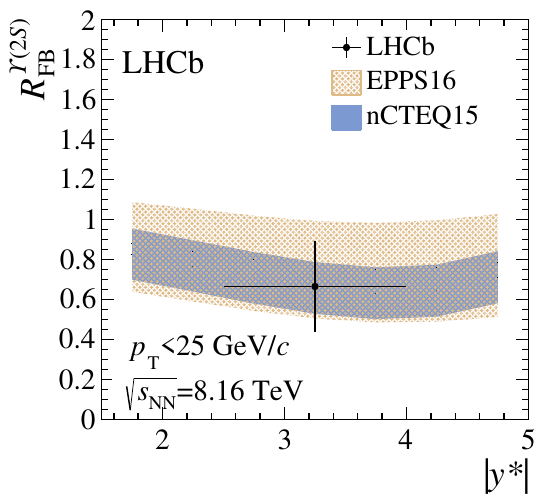
Figure 9 . Forward-backward ratio for the (cid:7) (2 S ) compared with theoretical calculations for the nCTEQ15 and EPPS16 nPDFs sets as reported in the